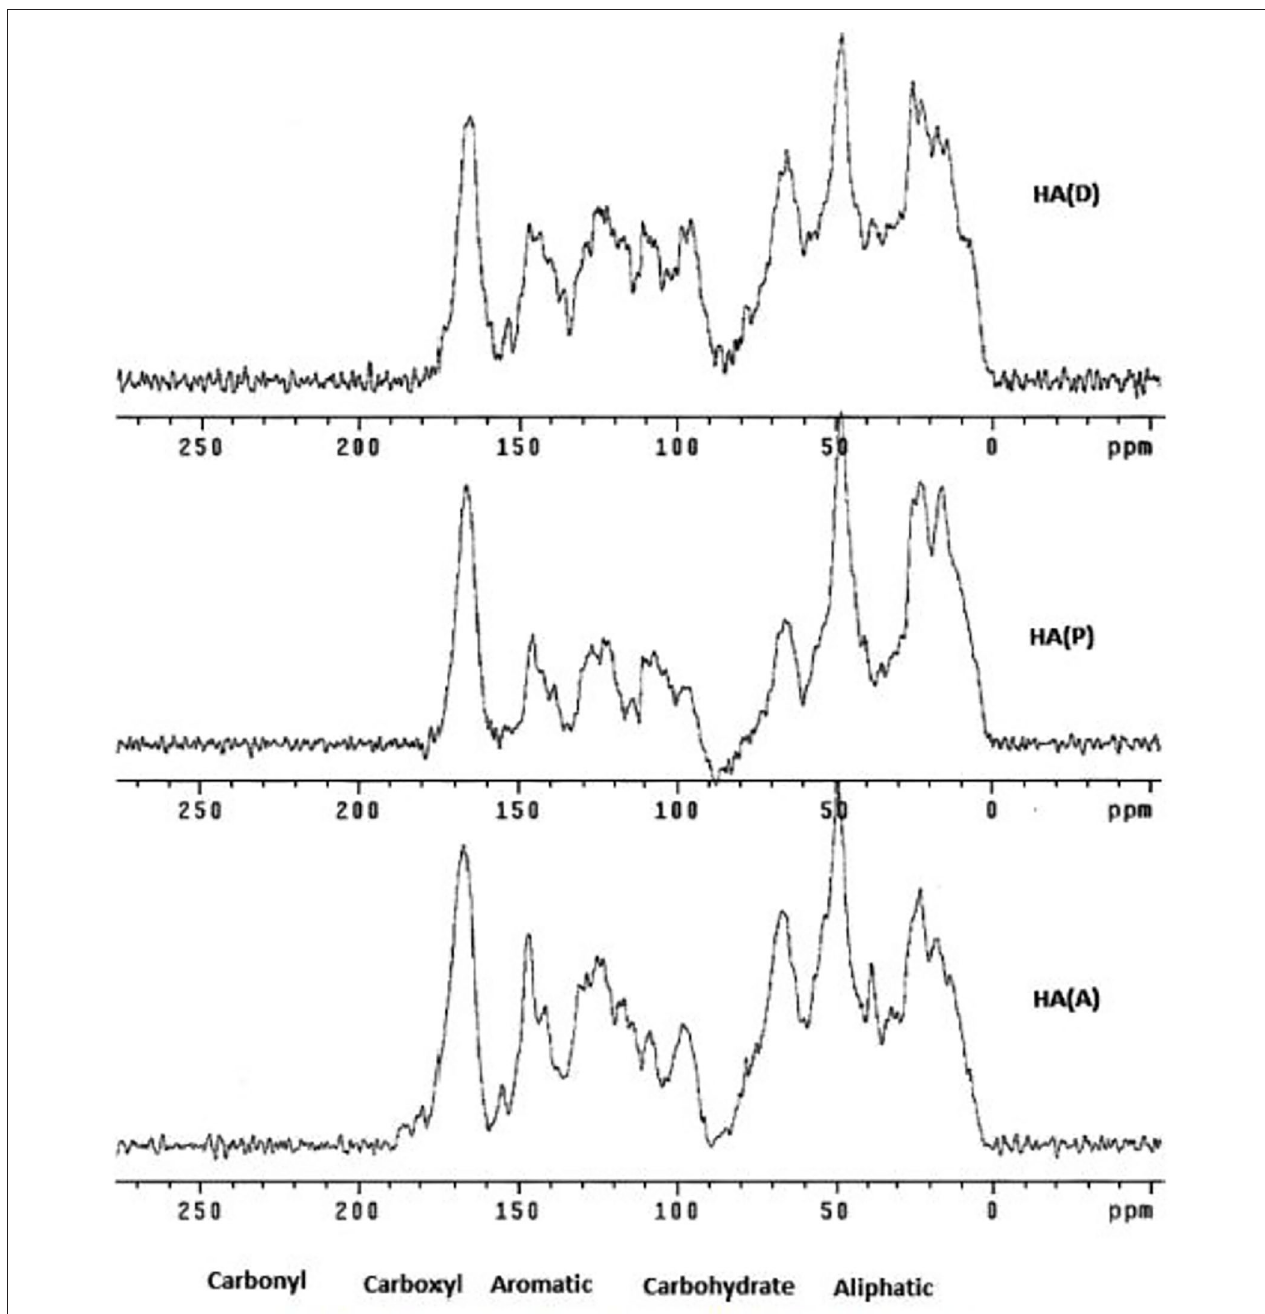
FIGURE 2 | CP-MAS-SS NMR spectrum of a humic acid (Faiyaz,